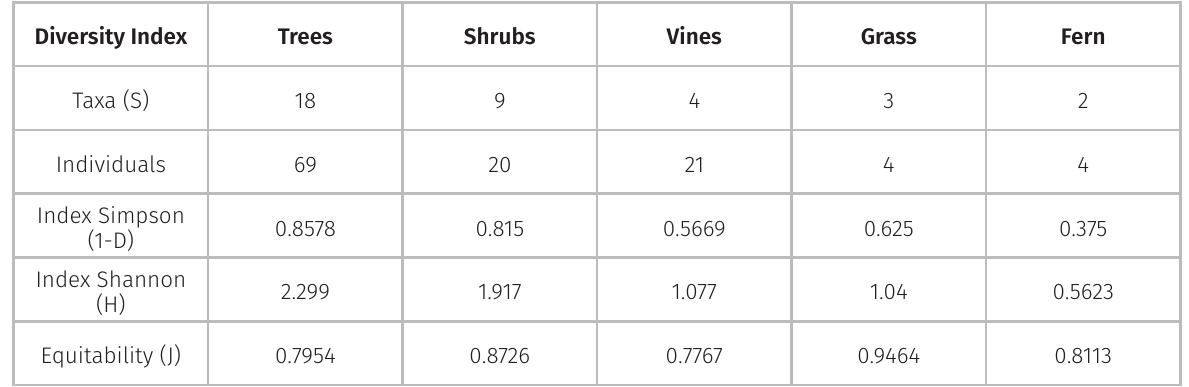
Table II. Index of diversity for trees, shrubs, vines and grasses used by Cicadellidae. Diversity Index Trees Shrubs Vines Grass